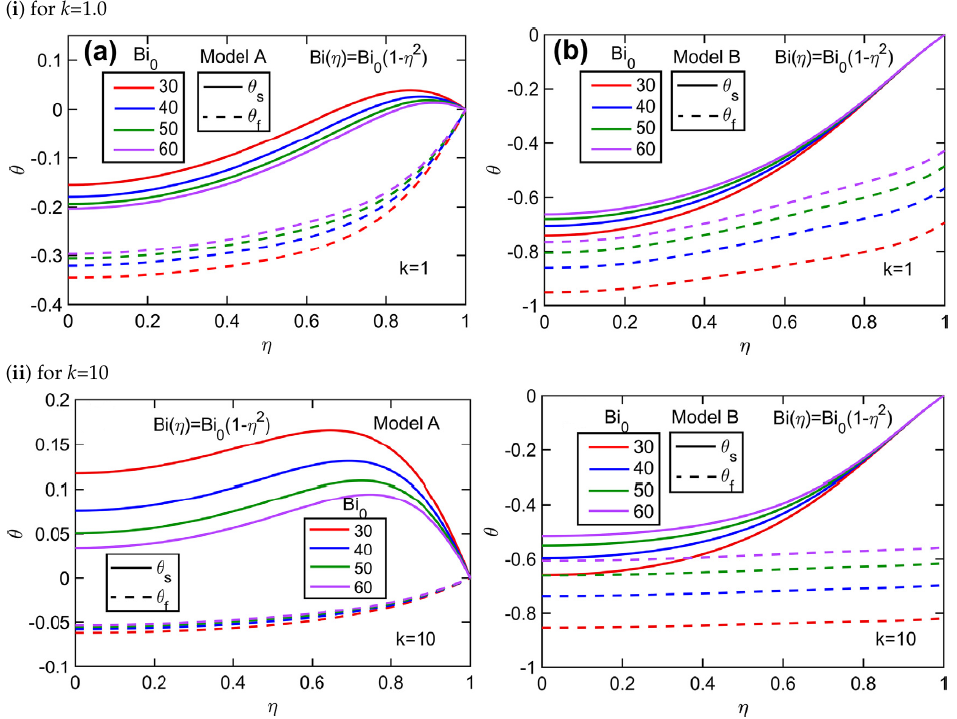
Figure 31. Temperature profiles of parabolic Biot number, for thermal conductivity ratio ( i ) k = 1 and ( ii ) k = 10, and for ( a ) model ( A ) and ( b ) model ( B ), of boundary conditions, reported by Parhizi et al. [55].